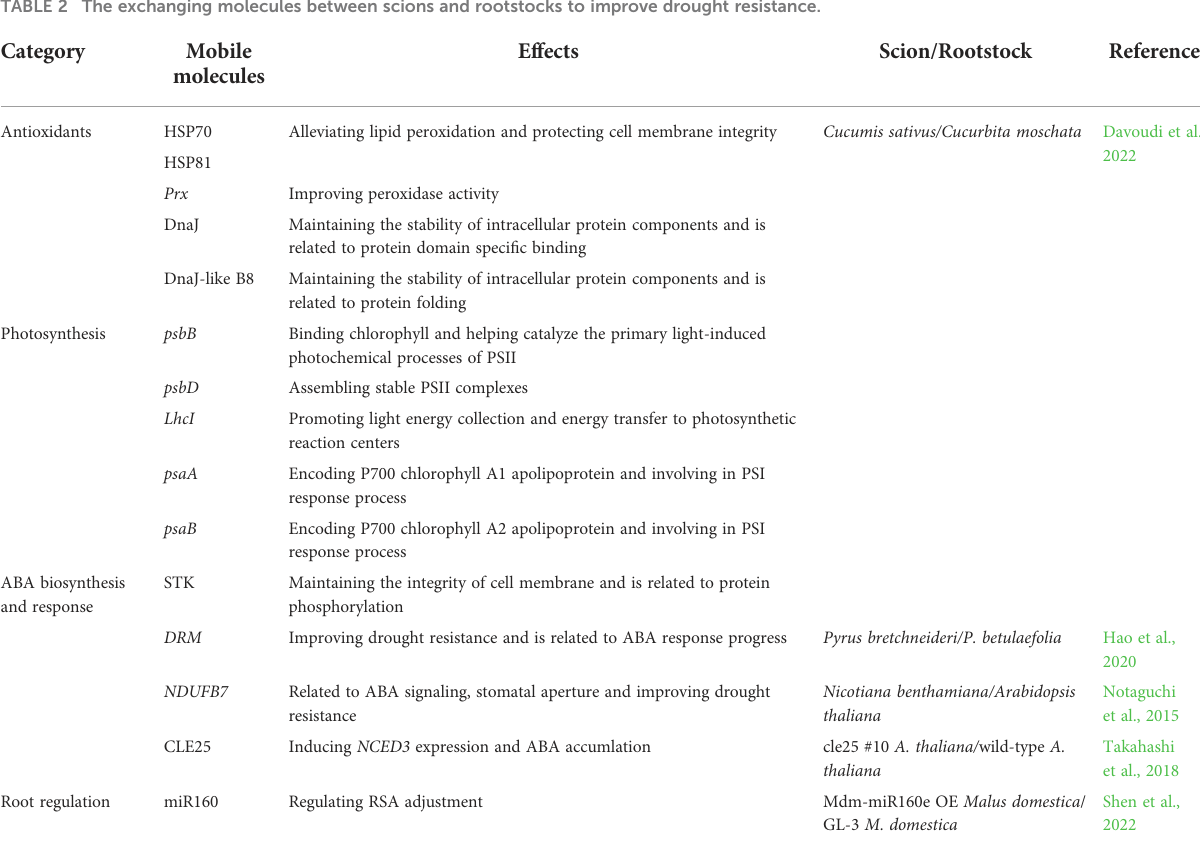
TABLE 2 The exchanging molecules between scions and rootstocks to improve drought resistance.